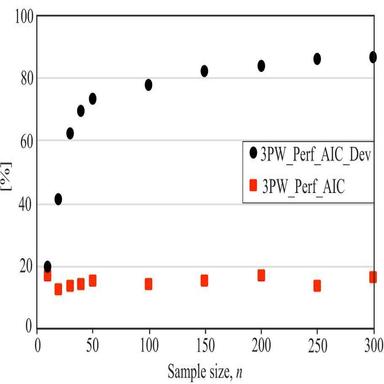
Fitting performance of 3P-Weibull distribution function as a function of sample size.